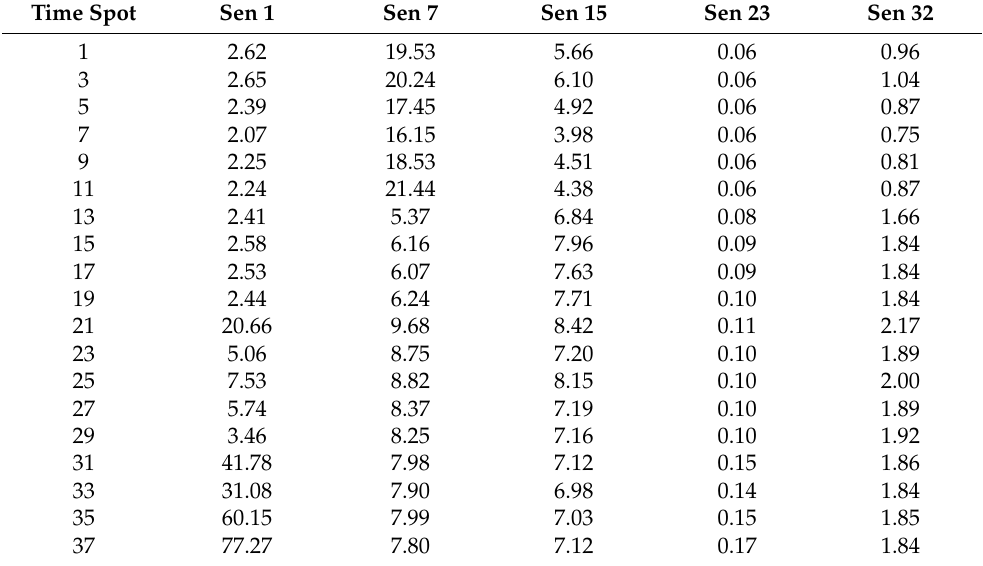
Table 4. Partial wavelet transform data of